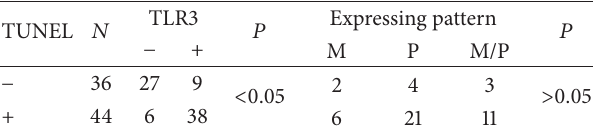
Table 5: Correlation between TUNEL expression and TLR3 expres- sion in